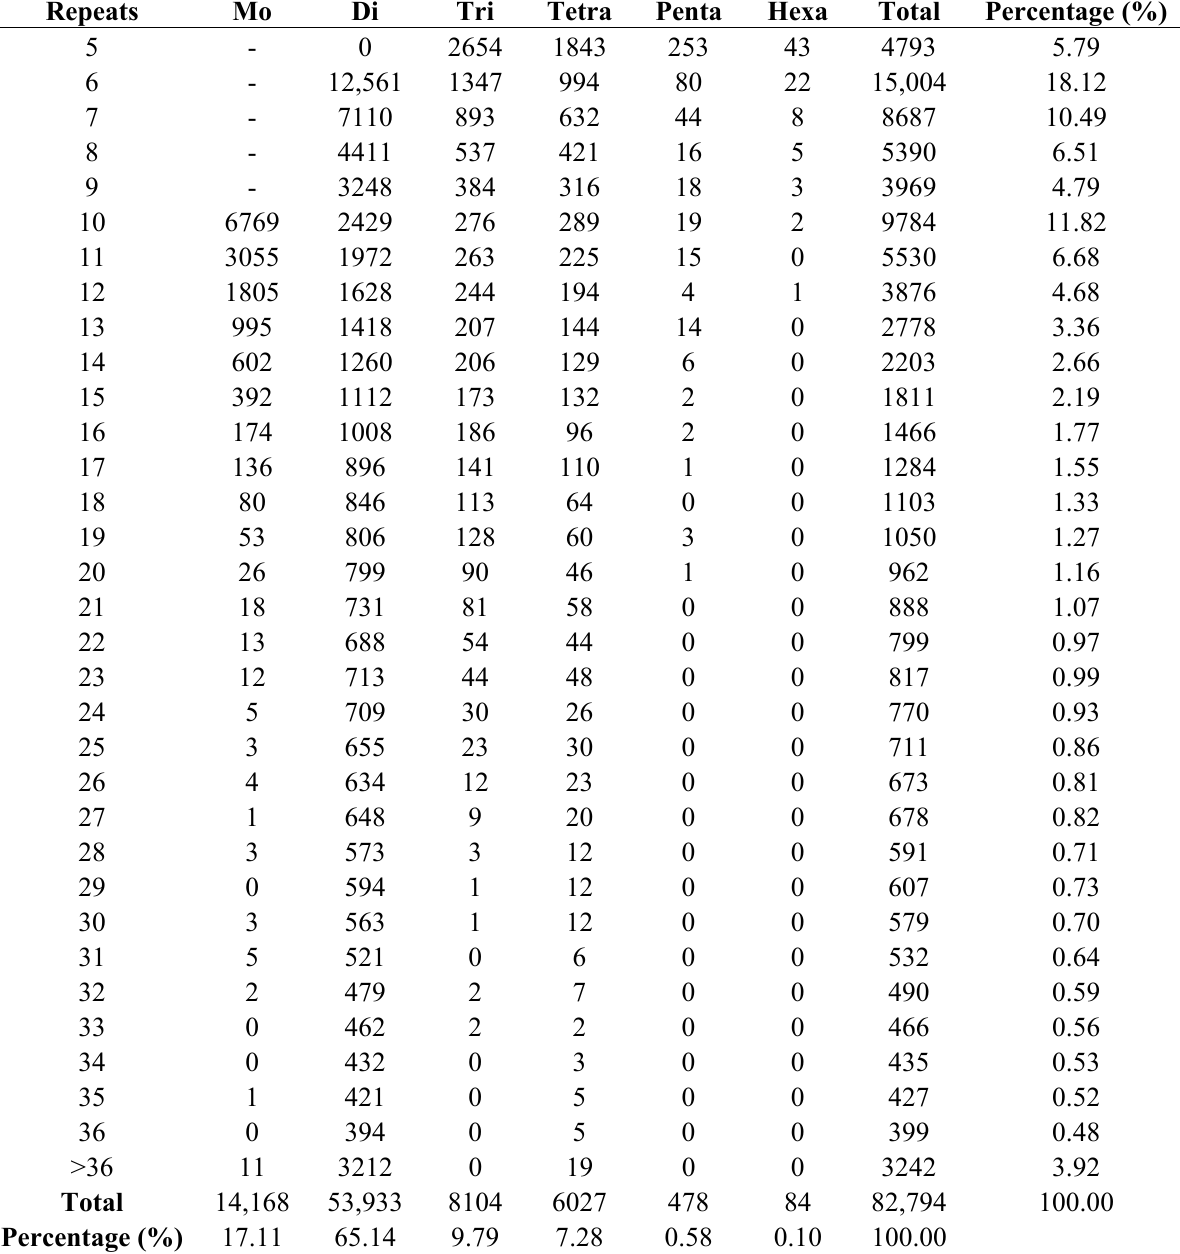
Table 1. Frequency of different repeat motifs among the EST-SSRs of yellow catfish.